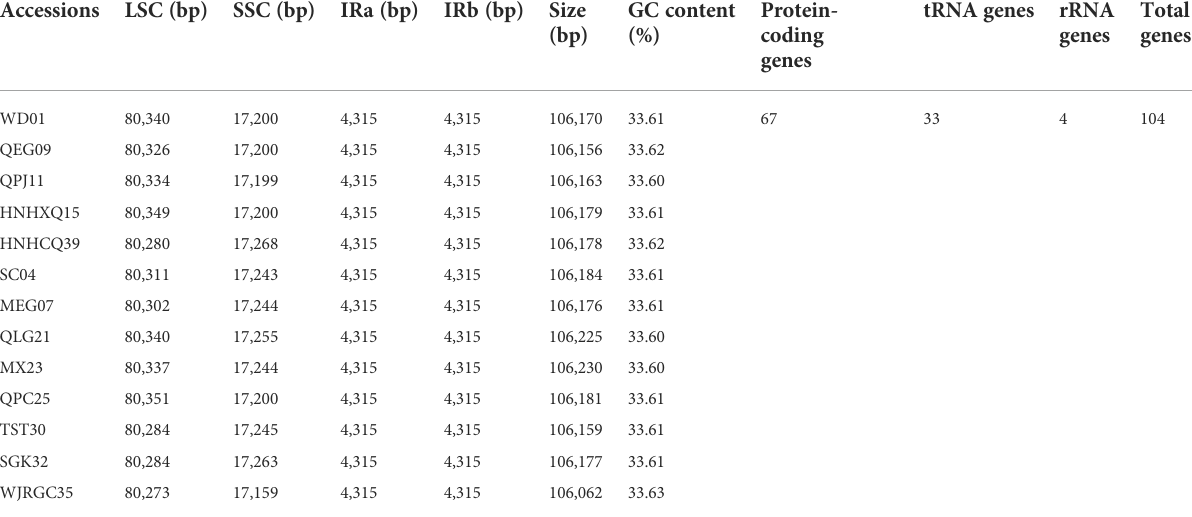
TABLE 2 Summary of the 13 T. mongolica chloroplast genomes.